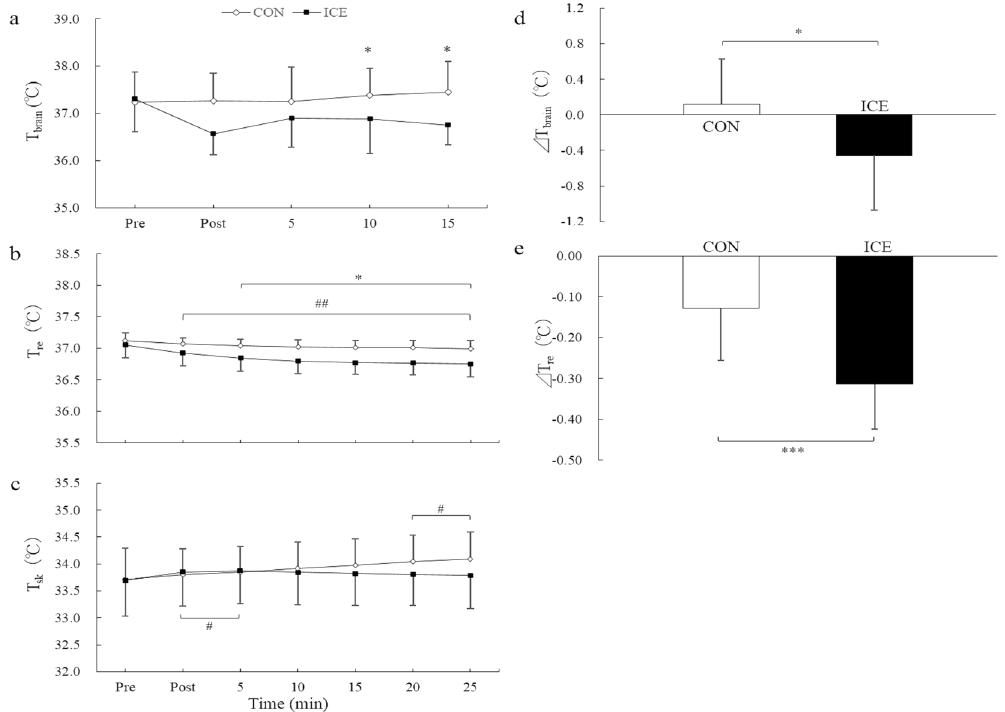
Figure 3. Changes in temperature over time. Changes in ( a ) brain temperature, ( b ) rectal temperature, and ( c ) mean skin temperature during the experiment. Mean changes in ( d ) brain temperature and ( e ) rectal temperature from before and after the experiment. The white rhombus shows CON and the black square shows ICE. Values are expressed as mean ± standard deviation. Significant different between conditions: * p < 0.05; *** p < 0.001. Significantly different than Pre: # p < 0.05; ## p < 0.01.